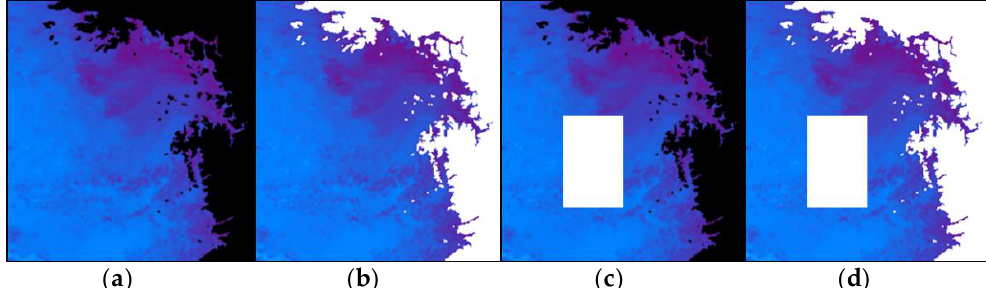
Figure 1. Examples of ( a ) ground truth of ocean satellite images, ( b ) land areas indicated by the land mask (white pixel values), ( c ) training image overlapped with the random mask to be restored, and ( d ) training image overlapped with both the land mask and random mask.